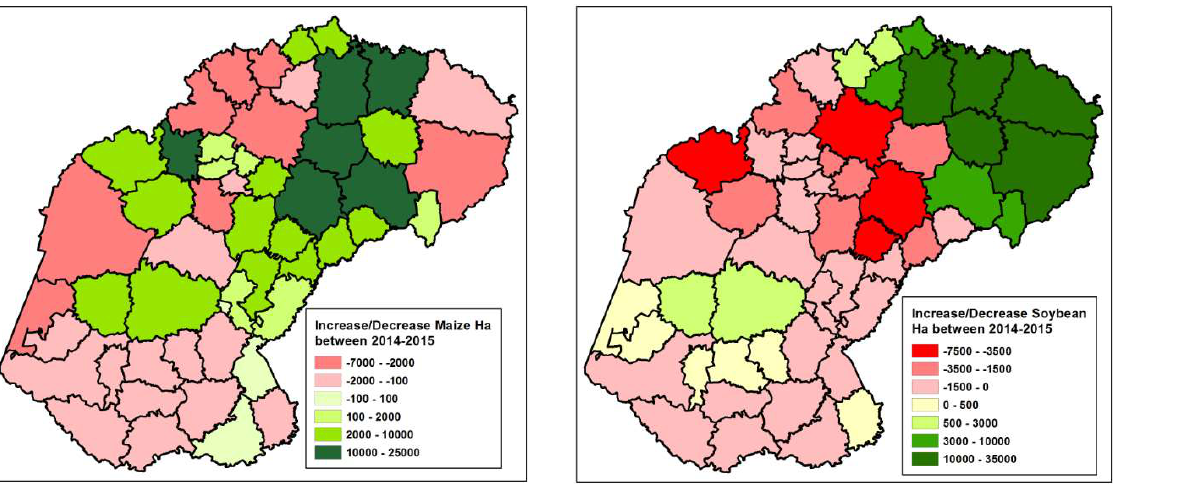
Figure 12. Calculated increase or decrease in area (Ha) of maize cultivated in 2014 and 2015 in Freestate